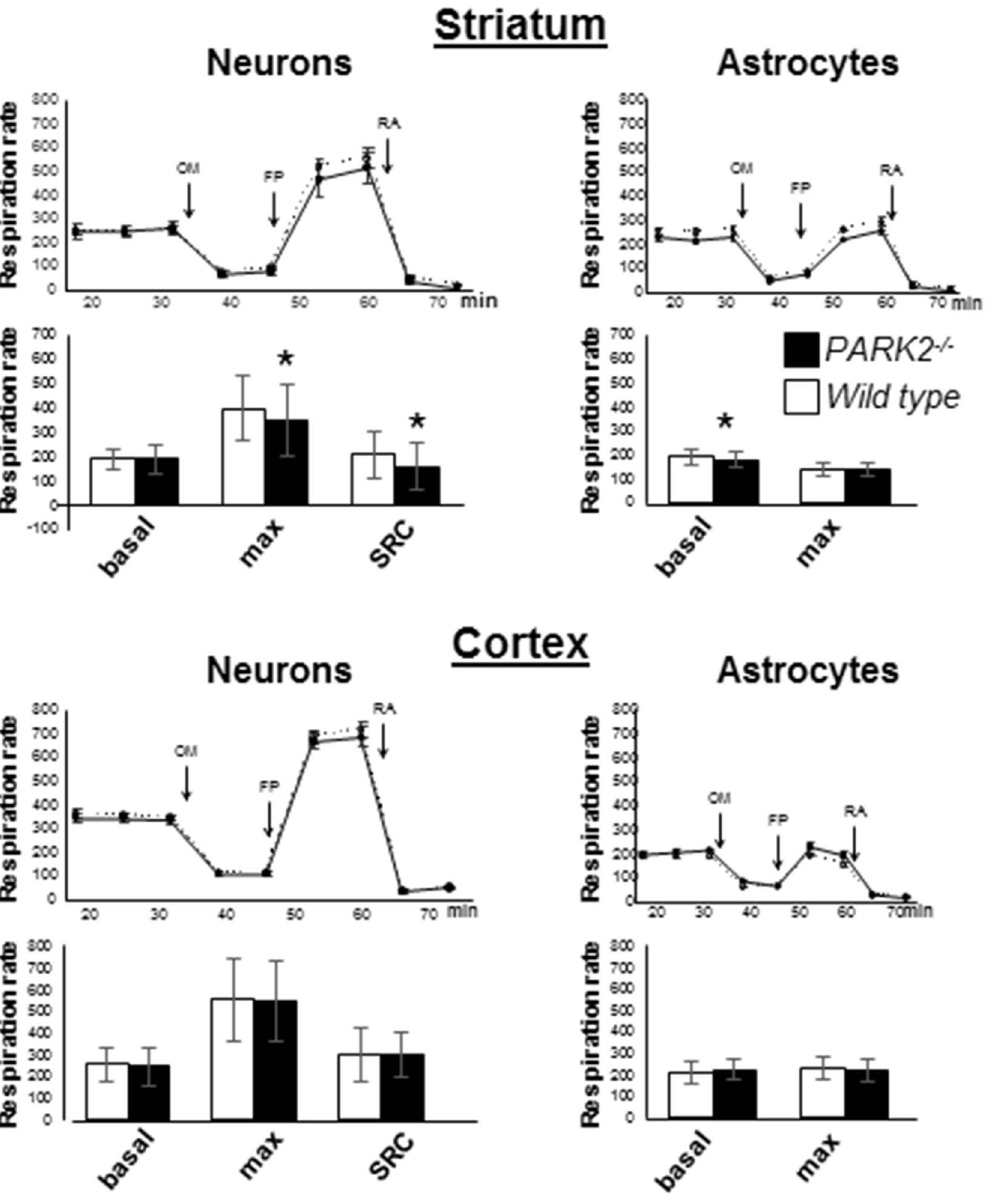
Figure 3. Maximal respiration is reduced in striatal neurons from PARK2 2 / 2 mice. Representative experiments with neurons or astrocytes from striatum or cortex: the traces represent the evolution of the respiration rate (in pmol O 2 /minute) in Seahorse plates seeded with cells from PARK2 2 / 2 (black circles) and wild type (white circles) mice. Sequential additions are: oligomycin (OM) (0.25 m g/ml for neurons and 0.5 m g/ml for astrocytes), fccp (FP) (3 m M for cortical neurons and 1 m M for other cells), and rotenone + antimycine (RA) (50 nM rotenone + 150 m g/ml antimycin A). Bars below the traces show the means and SD of basal respiration, maximal respiration and spare respiratory capacity (SRC=maximal – basal respiration) of 3 independent tests, each performed in 6 to 12 independent wells. * p , 0.05 using Mann and Whitney